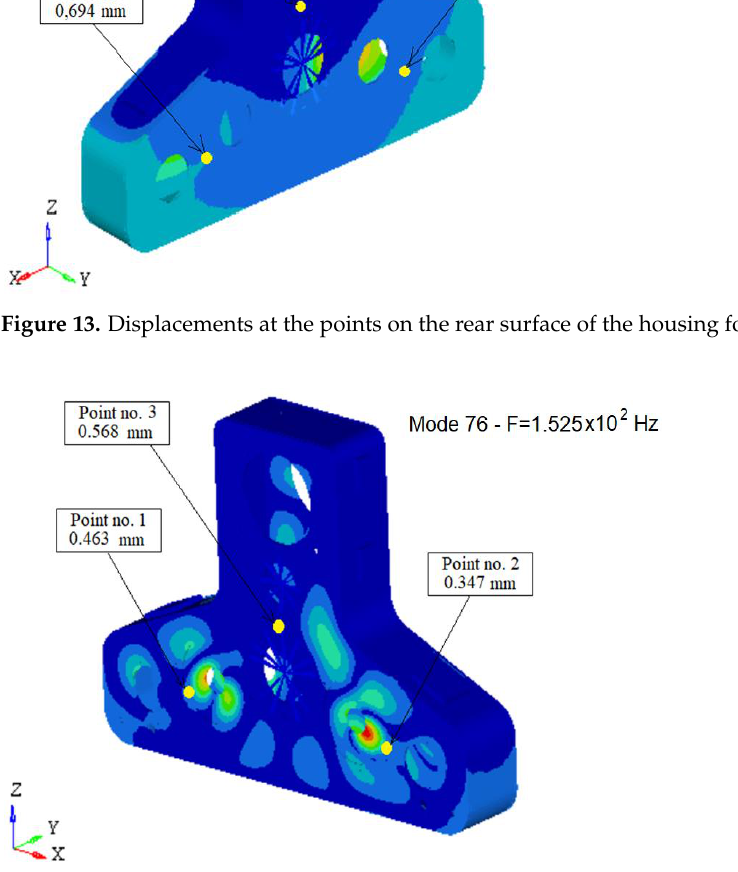
Figure 15. Displacements of the points on the rear surface of the housing for mode 76. In this section, the structural and modal analysis of the adder and distribution box housing was performed with the finite element method using the ABAQUS program and experimental determinations of the housing material characteristics. In conclusion, we can highlight the following aspects: 1. The structural analysis highlighted the distribution of unitary efforts on the surfaces of the box housing. 2. For the maximum load of the box (maximum transmitted moment), the greatest ef- forts are distributed in the power take-off area. 3. The highest value of the effort is 88.229 N/mm 2 in the area of the large cover assem- bled by screws, close to the left side edge.